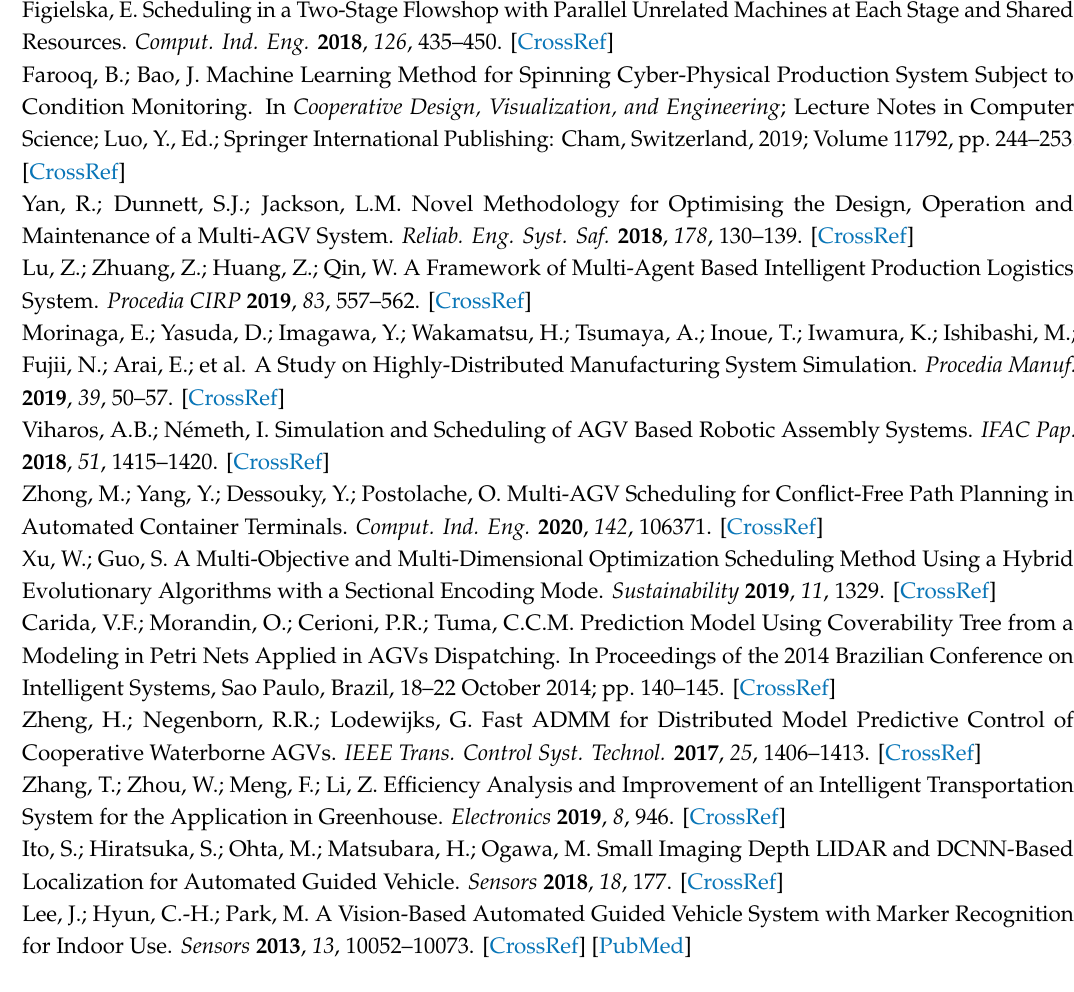
Figielska, E. Scheduling in a Two-Stage Flowshop with Parallel Unrelated Machines at Each Stage and